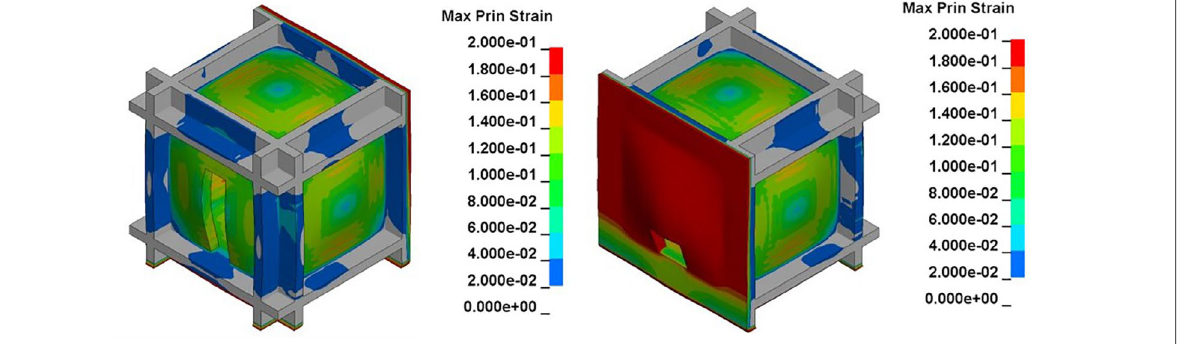
Fig. 25 Deformation